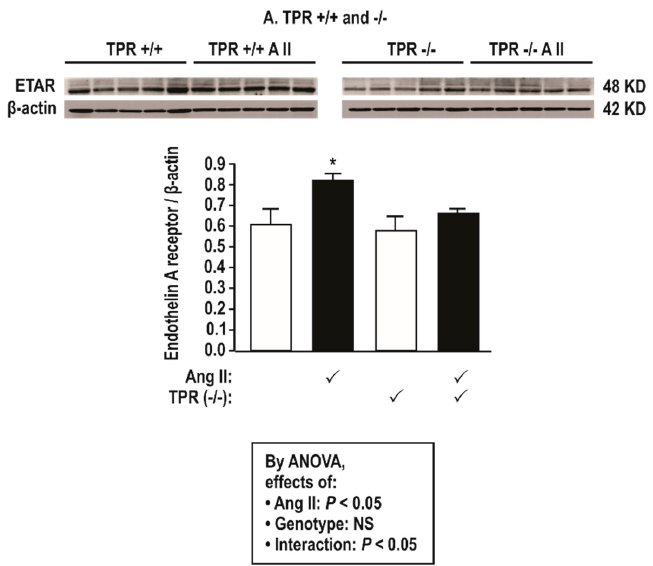
Figure 3. Angiotensin II infusion at 400 ng · kg − 1 min − 1 × 14 days increases mesenteric resistance arteriolar protein expression for endothelin type A receptors (ETARs) in thromboxane prostanoid receptor (TPR) wild type but not in knockout mice. Mean ± SEM values ( n = 5 per group). Compared to without angiotensin II infusion: *, P < 0.05.